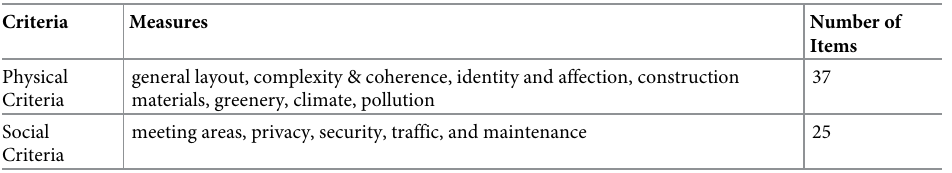
Table 1. POE items from cross’s